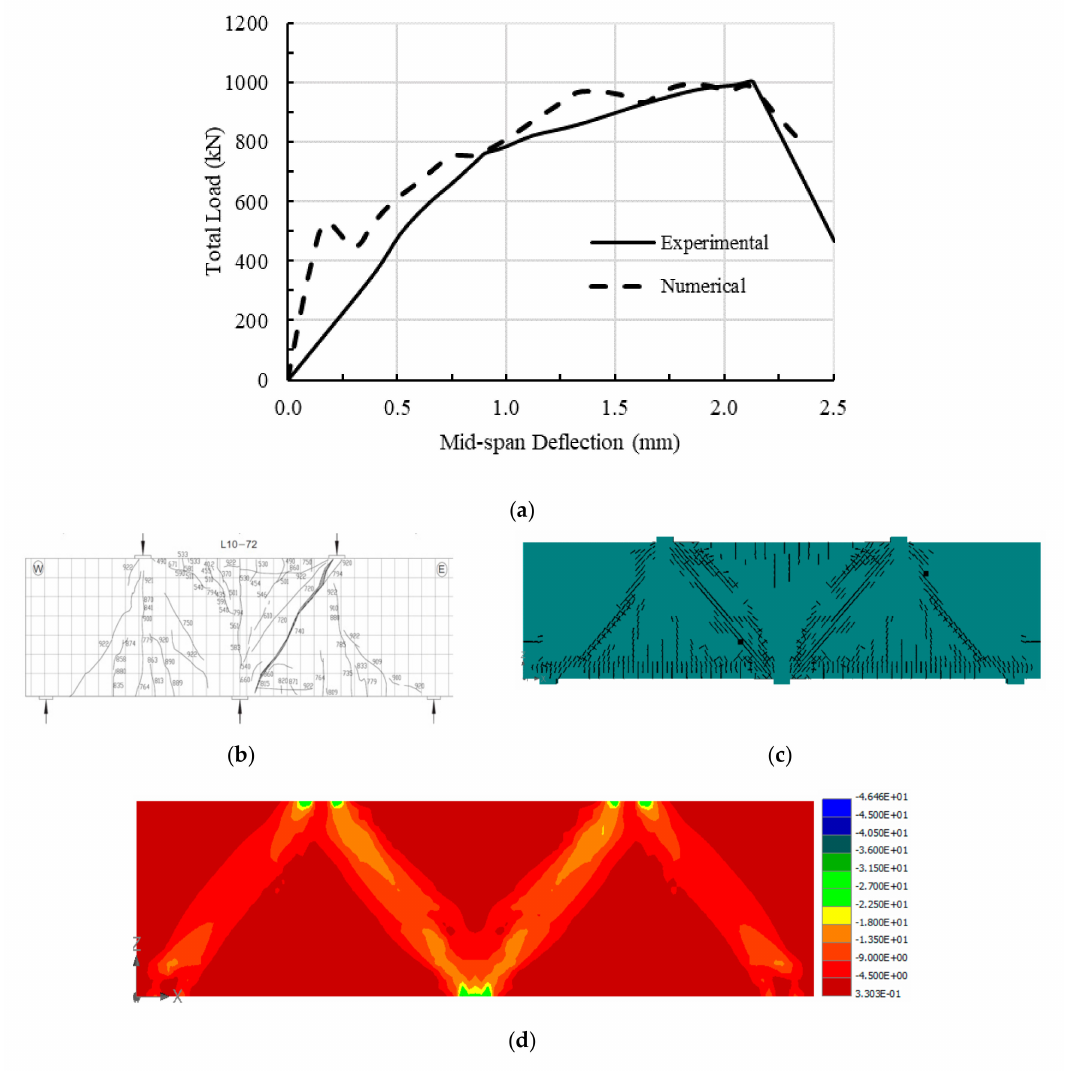
Figure 8. Experimental and numerical responses of specimen L10-72 (RHR supports): ( a ) Experimental [9] and numerical load-deflection curves for specimen L10-72; ( b ) experimental crack pattern [9]; ( c ) numerical crack pattern; ( d ) stress distribution